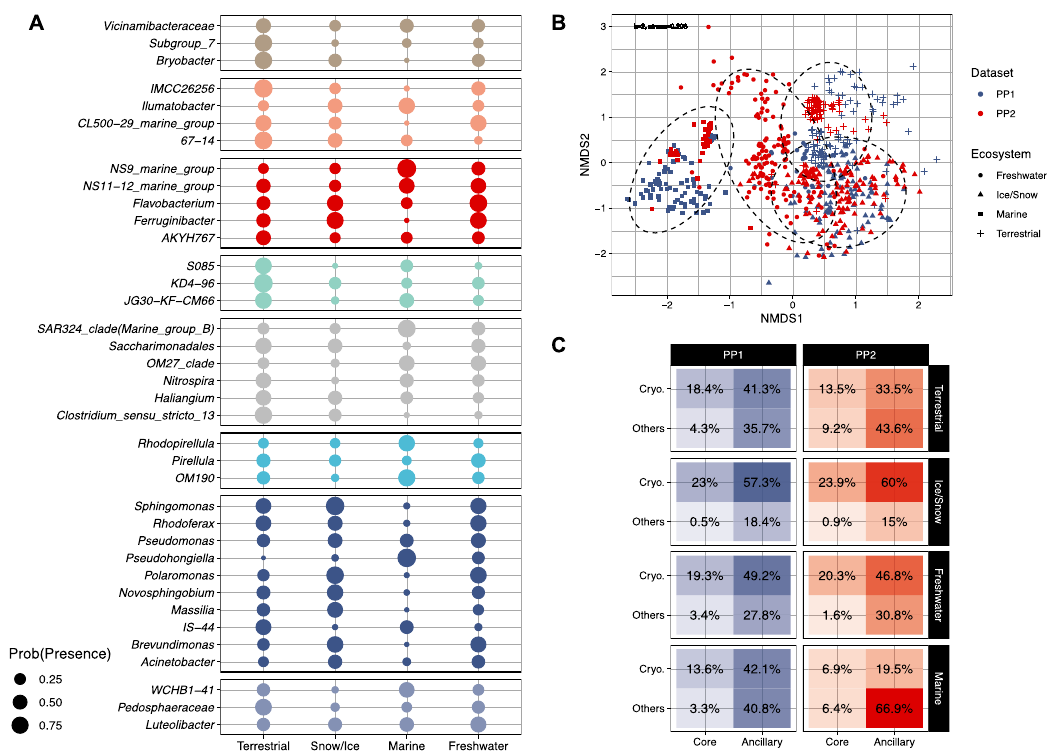
Fig. 3 Microbiome structure across various cryospheric ecosystems. A The probability of presence of members of the core microbiome is shown across cryospheric environments. Colours and facets separate phylum-level taxonomic af fi liation. B Unconstrained ordination showing differences (Bray-Curtis dissimilarity) of bacterial communities among different cryospheric ecosystems ( k = 2, stress = 0.206). Hulls demark 95% con fi dence intervals for a multivariate t distribution for the respective ecosystem types. C Mean relative abundance (in percentage) of core/ancillary and cryospheric/others bacterial genera across the four ecosystem types and the two primer pairs. Source data are provided as a Source Data fi